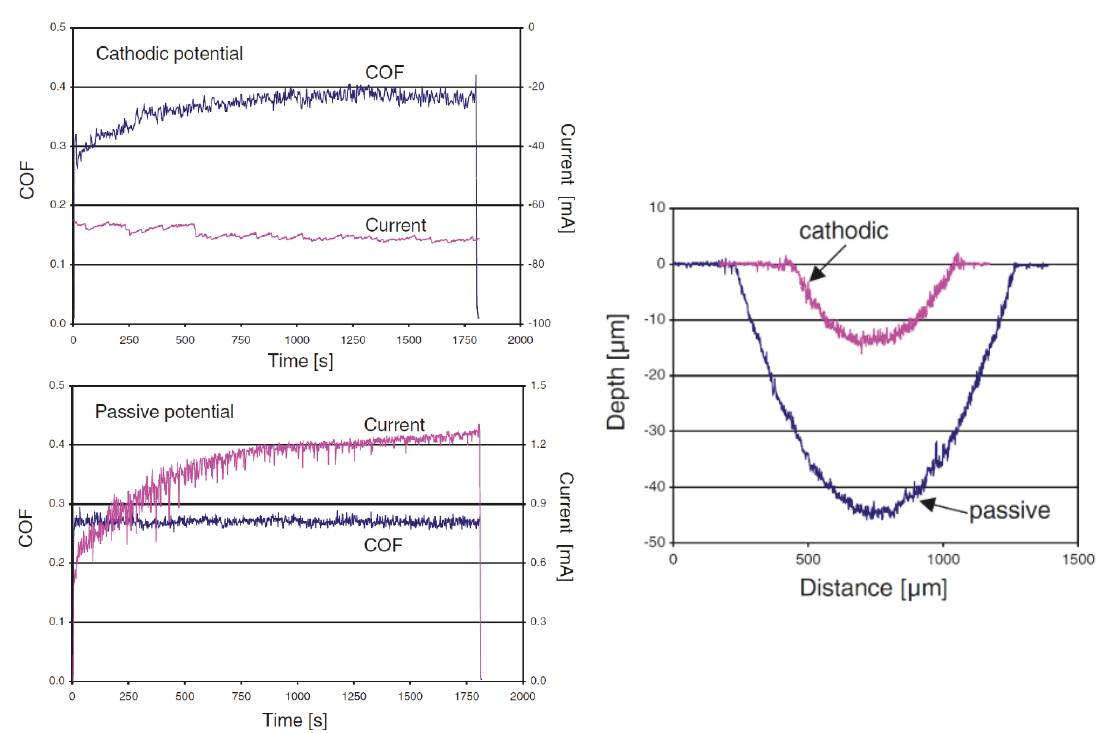
Figure 5: Effect of potential on the coefficient of friction and current during sliding (left) and on the wear track volume for a 316L steel in H 2 SO 4 at cathodic (-1.5V) and passive (0V) potentials. The current values recorded are higher and the coefficient of friction is lower for passive potentials. The material loss at passive potentials is considerably higher due to wear-accelerated corrosion